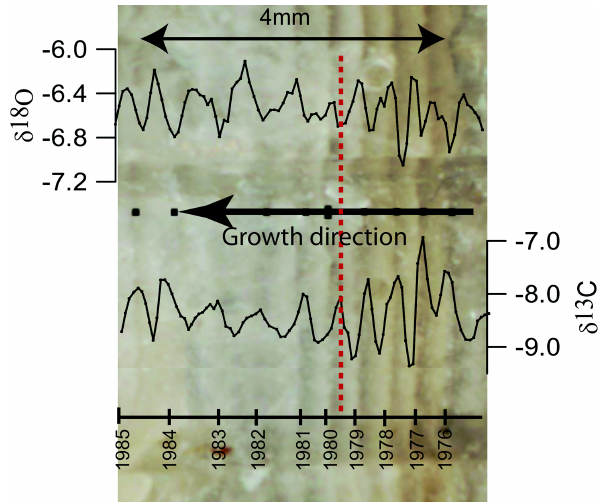
Figure 4. The δ 18 O and δ 13 C signals, reported in per mill VPDB, from the Proserpine stalagmite anticorrelate at monthly scale. Note that, in the scanned figure of the Proserpine slab, dark and com- pact layers become whiter due to the translucent light of the scan while the white and porous layers become dark. At the end of a dark compact layer (dotted line), the δ 18 O values reach their min- imum values, while the δ 13 C values reach their maximum. Dark layers are formed during summer, when cave temperatures are high (leading the low δ 18 O) and PCP increases (leading to high δ 13 C). The clearer the lamination, the larger the amplitude of the variations in the isotopic composition.